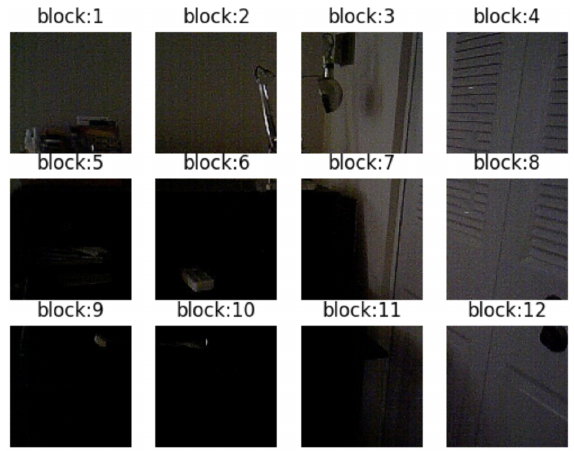
Figure 7. Image block